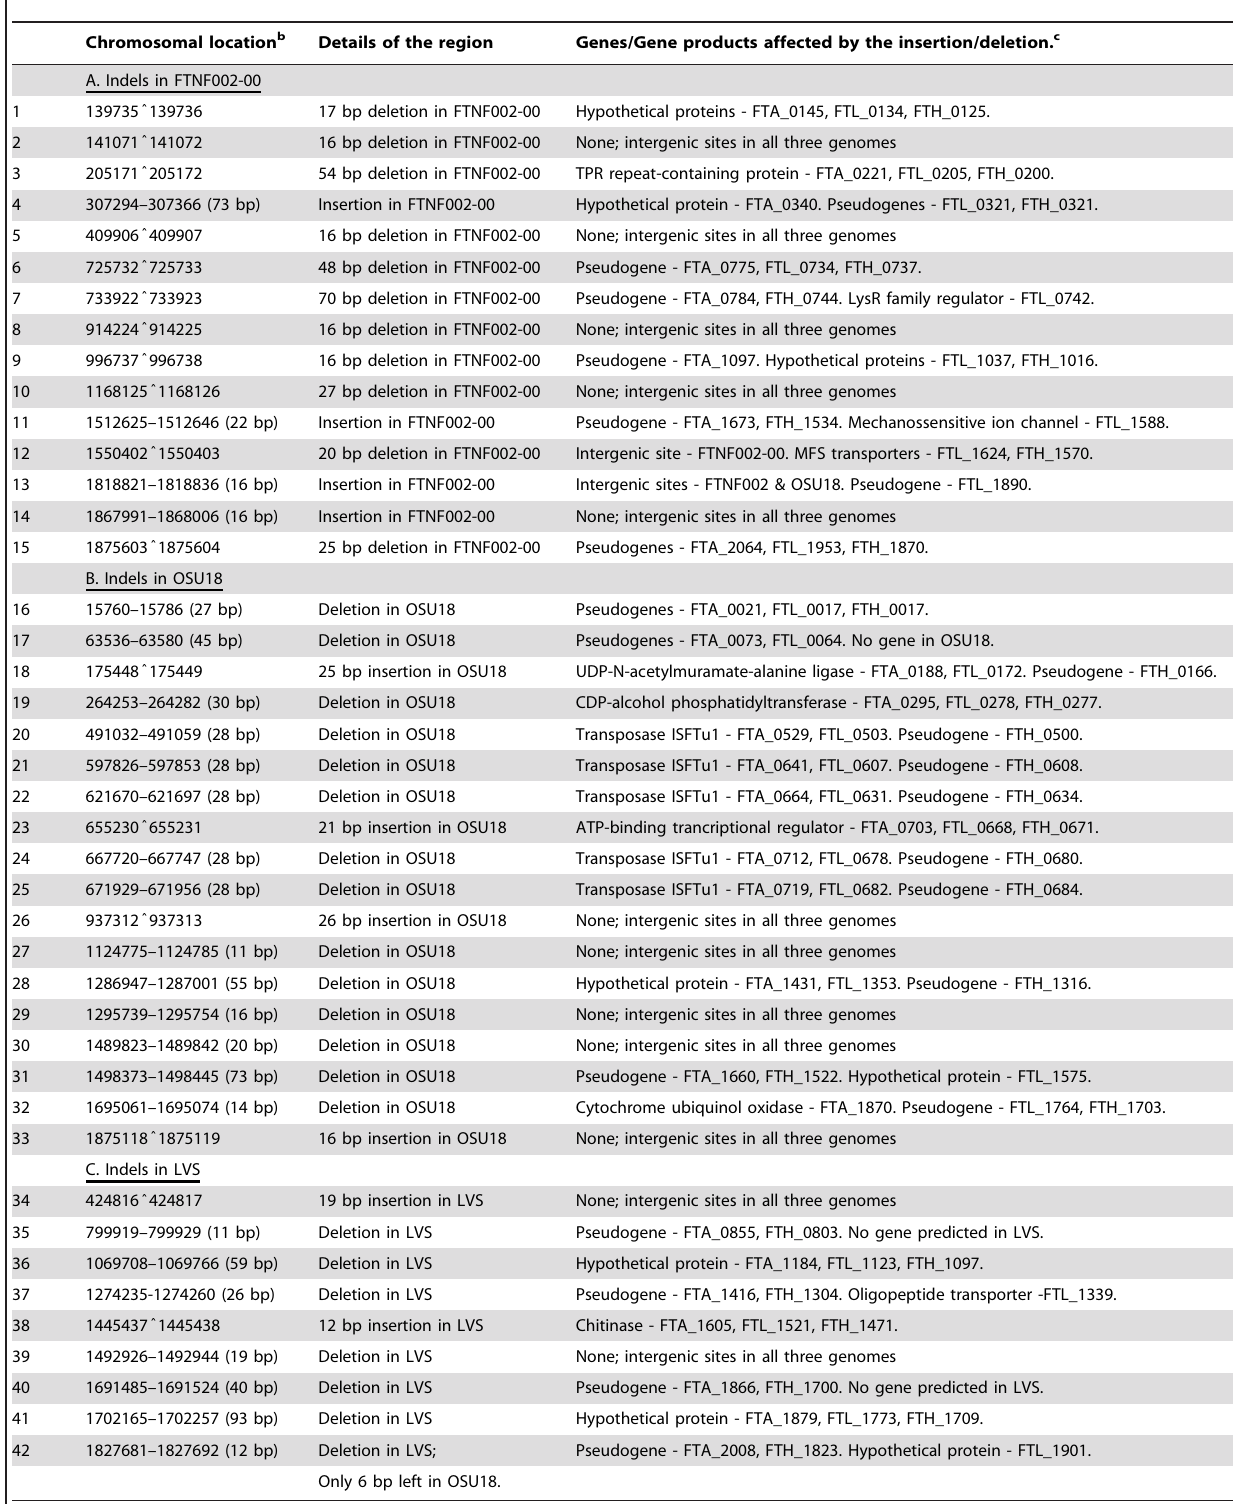
Table 3. Small insertions and deletions (Indels) in the holarctica genomes.